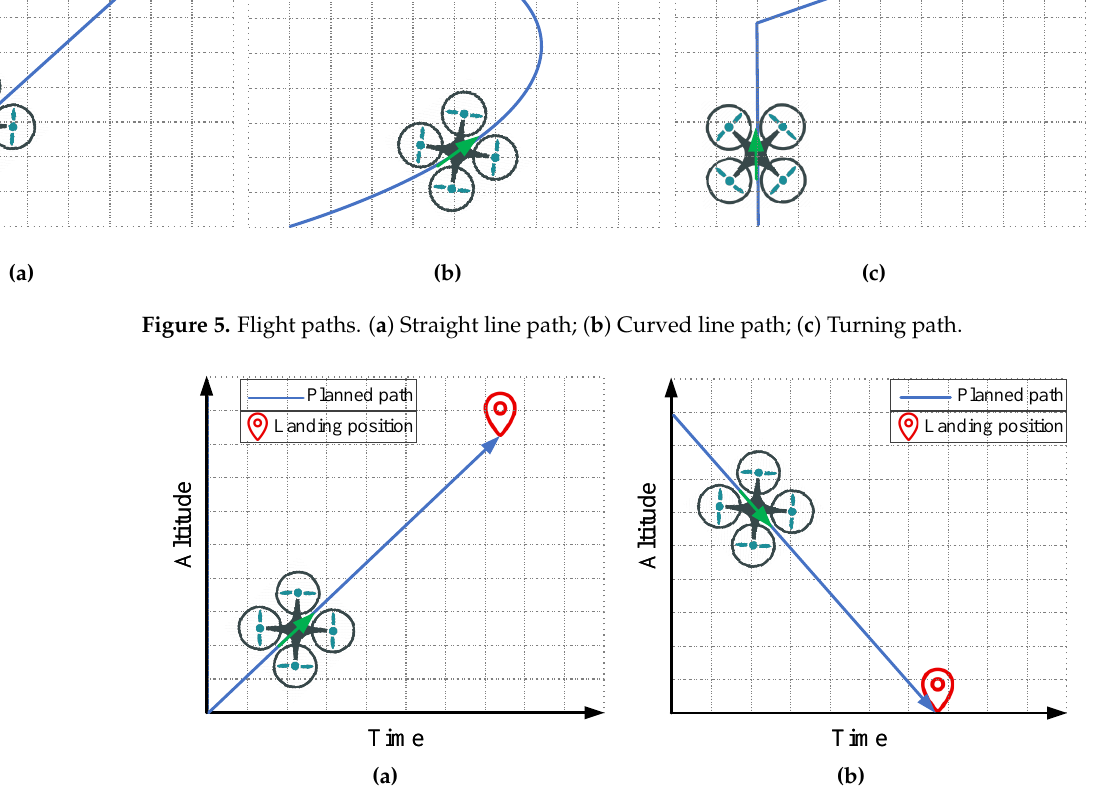
Figure 6. Flight paths. ( a ) Ascending path (from a low position to a high position); ( b ) Descending path (from a high position to a low